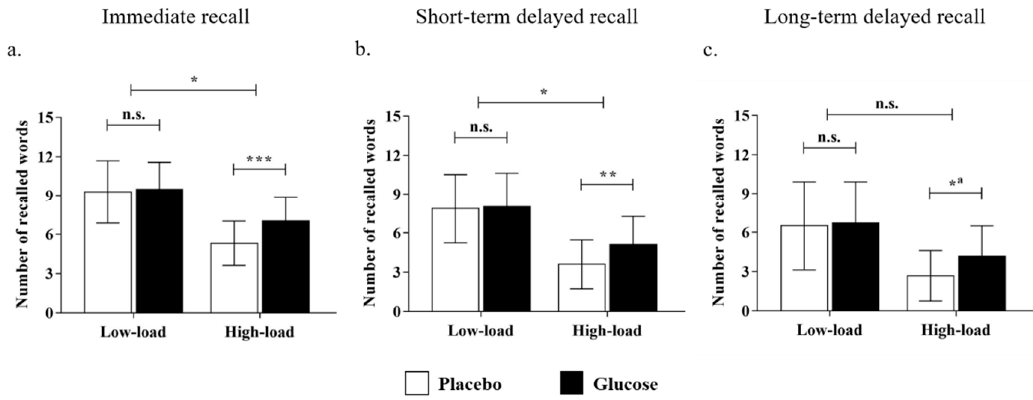
Figure 3. The number of recalled words out of 15 after the intake of a drink (glucose/placebo) in the low- and high-load conditions for the ( a ) immediate recall, ( b ) short-term delayed recall, and ( c ) long-term delayed recall. Note: * p < 0.05; ** p < 0.01; *** p < 0.001; n.s. = non-significant. a The interaction effect was not significant. Nevertheless, a simple effect analysis was conducted to show the